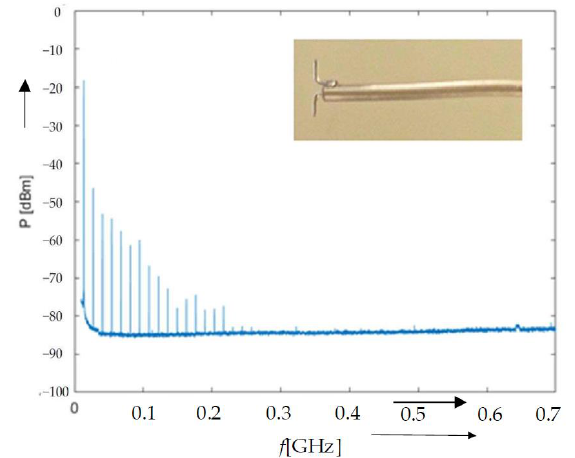
Figure 9. The measured frequency spectrum of the electromagnetic field irradiated by the plasma. The parameters and conditions included P out = 50 W, f g = 13.56 MHz, argon flow rate of v v = 3 L/min, contact between the plasma and the duralumin basis, jet orifice at the height of l = 10 mm, and frequency spectrum sensing accumulation of 50× ( f max = 0.7 GHz).